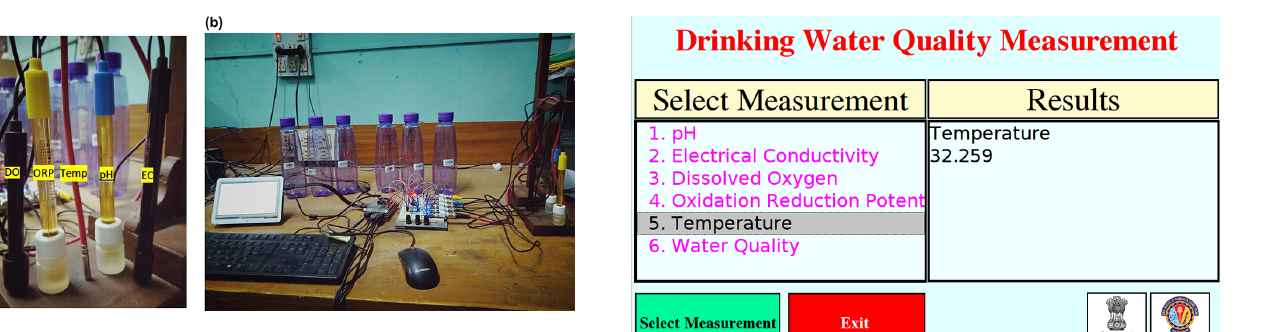
Figure 2. (a) Multi-sensor array (MSA). (b) Raspberry Pi integra- tion with MSA and peripherals.